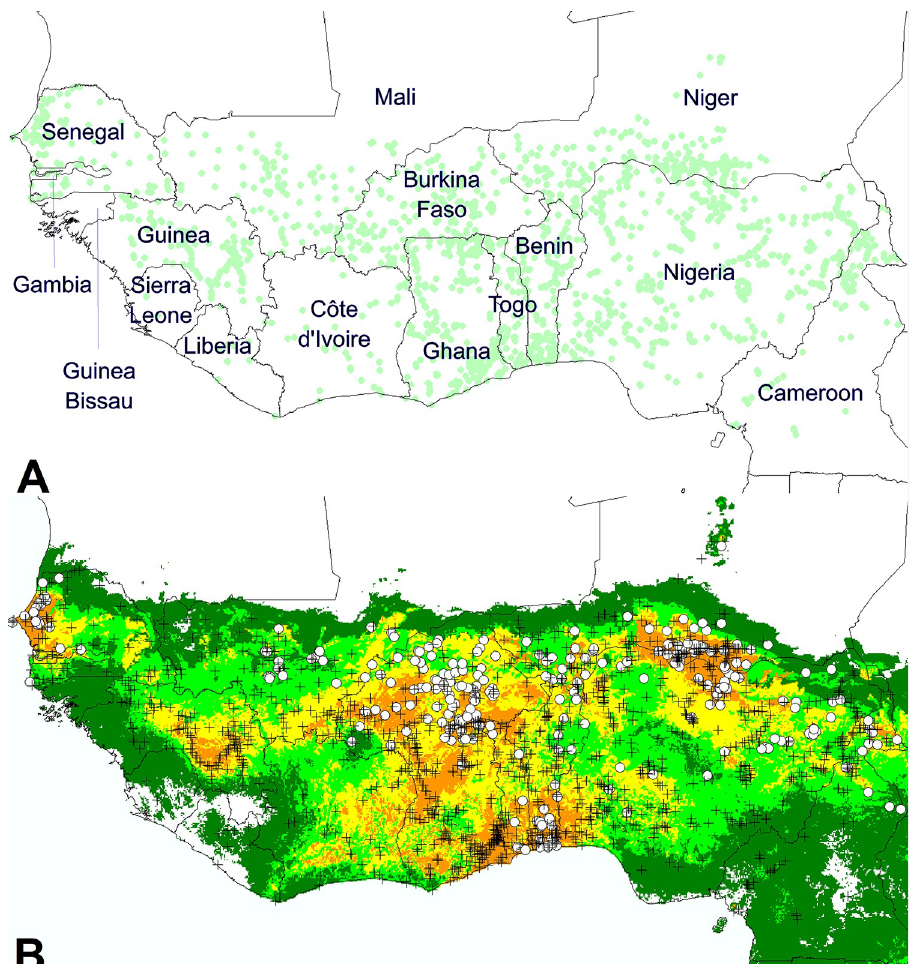
Fig 1. Geographic distribution of cultivated cowpea in West Africa. A. Region of study and global distribution of the 1747 datapoints of occurrence. B. Ecoclimatic model of cultivated cowpea distribution in West Africa. Cowpea datapoints are represented by black crosses, except for cases of cowpea infected by S . gesnerioides , represented by white circles. Background color indicates climate suitability: unsuitable (no color); marginal (dark green); favorable (light green; above 10 percentile training presence); very good (yellow; above 33 percentile training presence); excellent (orange; above 67 percentile training presence).